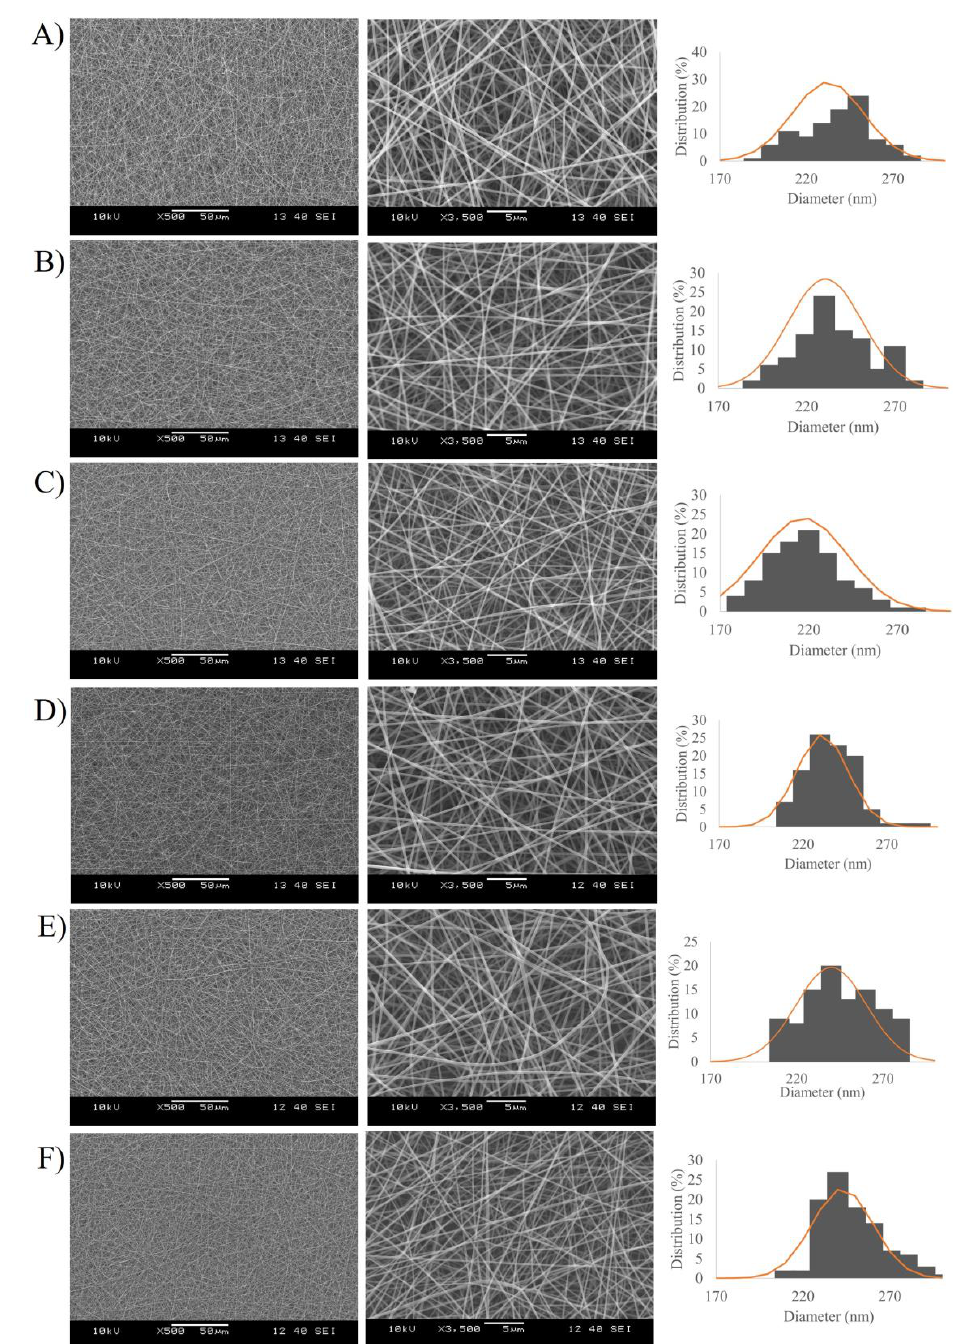
Figure 4. SEM images (magnification: 500× and 3500×) and diameter distribution of Melatonin - loaded PVA nanofibers with different concentration of drug 0.1% w/w ( A ), 0.3% w/w ( B ), 0.5% w/w ( C ), and Melatonin-loaded PVA nanofibers with Tween ® 80 and different concentrations of drug 0.1% w/w ( D ), 0.3% w/w ( E ), 0.5% w/w ( F ).